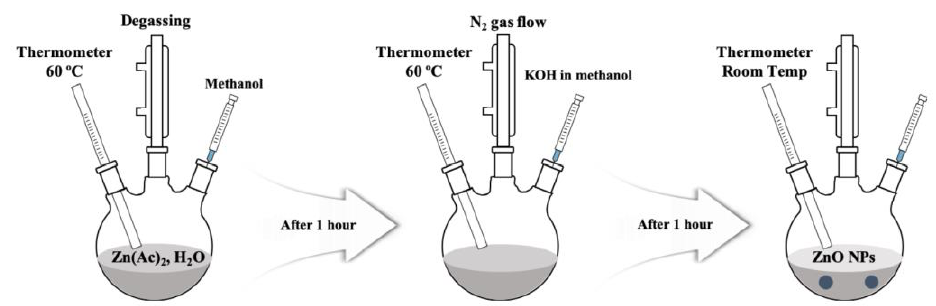
Figure 2. Schematic diagram of the synthesis of ZnO nanoparticles.